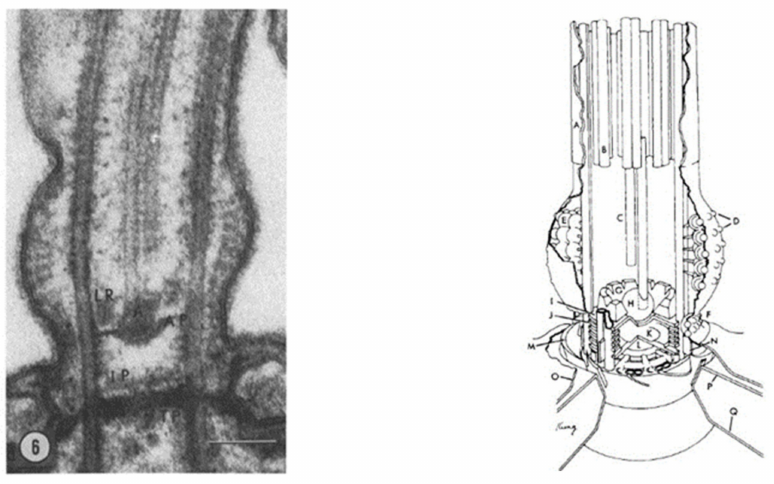
Figure 10. Ultrastructure of the Paramecium transition zone (A) cross-section of a Paramecium transi- tion zone showing the terminal plate (TP), intermediate plate (IP), and axosomal plate along with